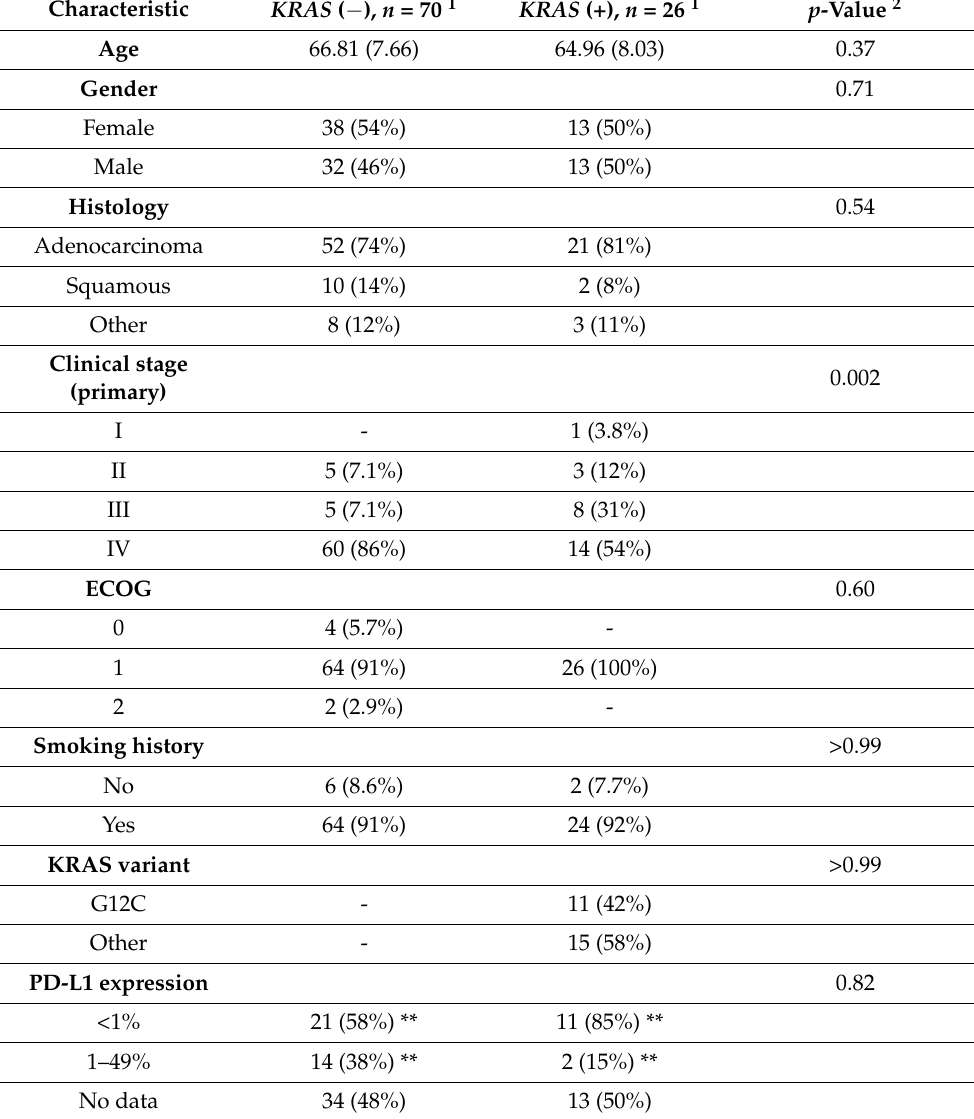
Table 1. Characteristics of